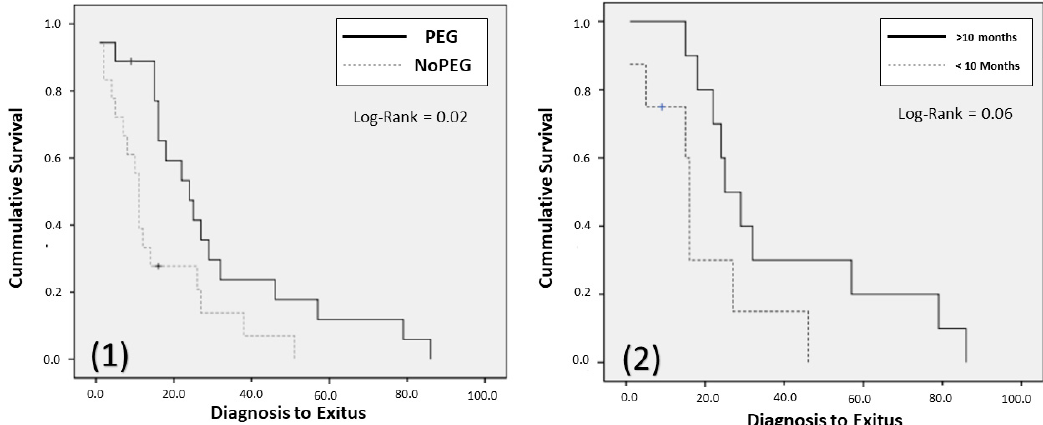
Figure 4. Kaplan–Meier curves: ( 1 ) Comparing survival in patients deceased in function of PEG implantation or not. PEG: implantation or not. PEG: Percutaneous Endoscopic Gastrostomy. ( 2 ) comparing survival in pa- Percutaneous Endoscopic Gastrostomy. ( 2 ) comparing survival in patients deceased in function of PEG early implanted (<10 months) or not (>10 months). PEG: percutaneous endoscopic